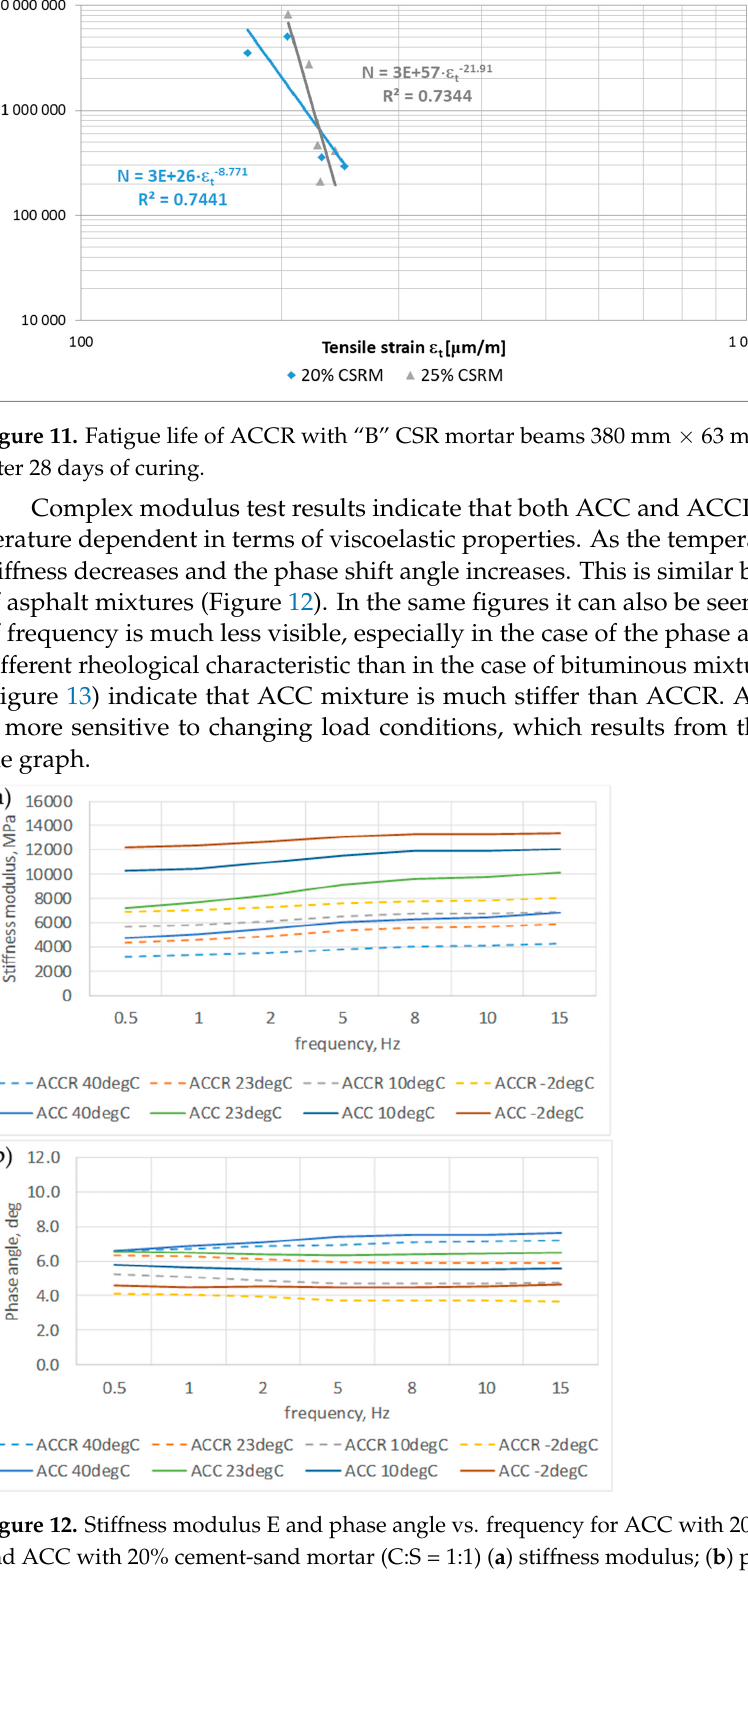
Figure 13. Master curves of stiffness modulus E and phase shift angle φ vs. reduced frequency for ACC with 20% of “B” CSR mortar and ACC with 20% cement-sand mortar (C:S = 1:1).